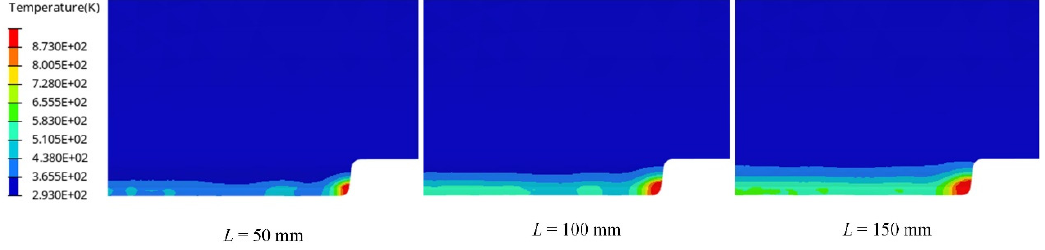
Figure 7. Tool temperature distribution during the cutting process.